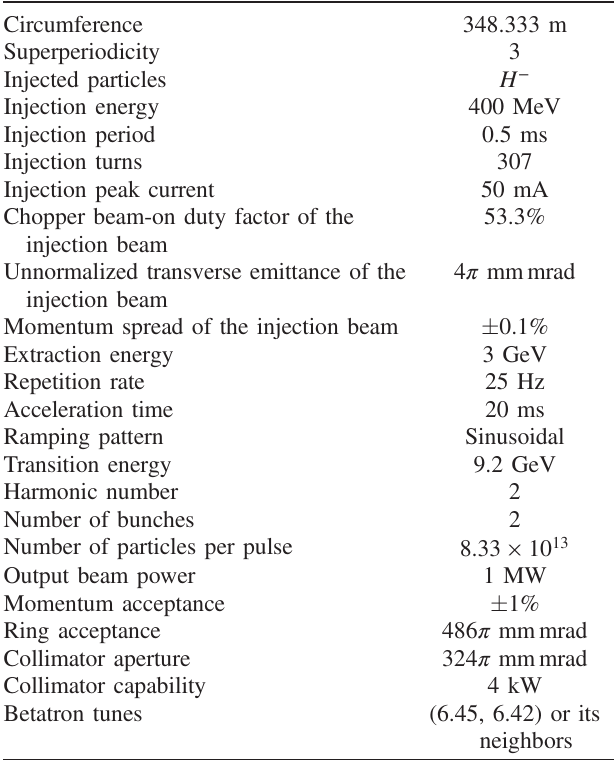
TABLE I. RCS design